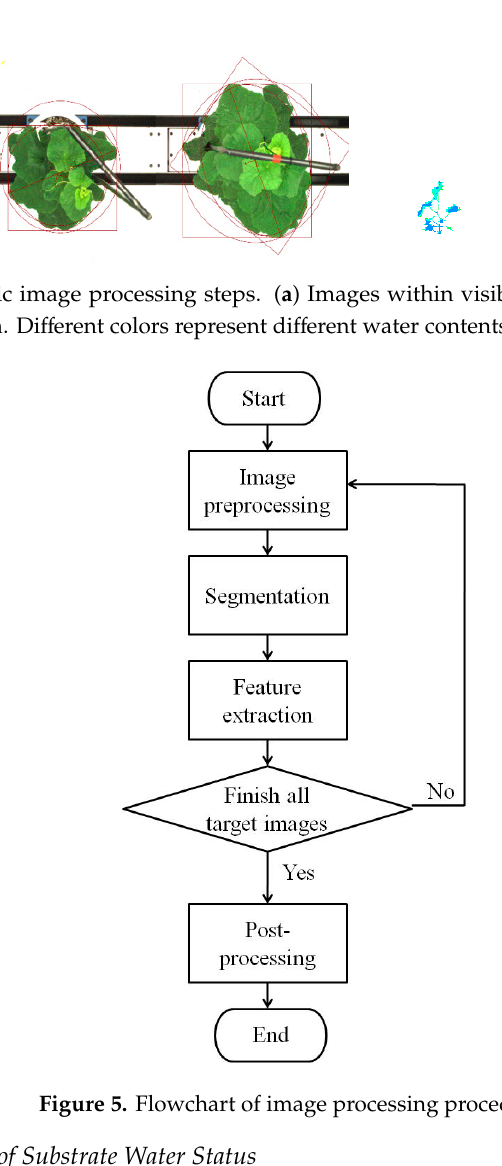
Figure 3. Muskmelon images acquired by Scanalyzer 3D (Lemna, Würselen, Germany) within visible ( a ) and near-infrared ( b ) spectra. From left to right of each panel were the images at seedling stage, vine elongation stage, and fruit development stage, respectively.